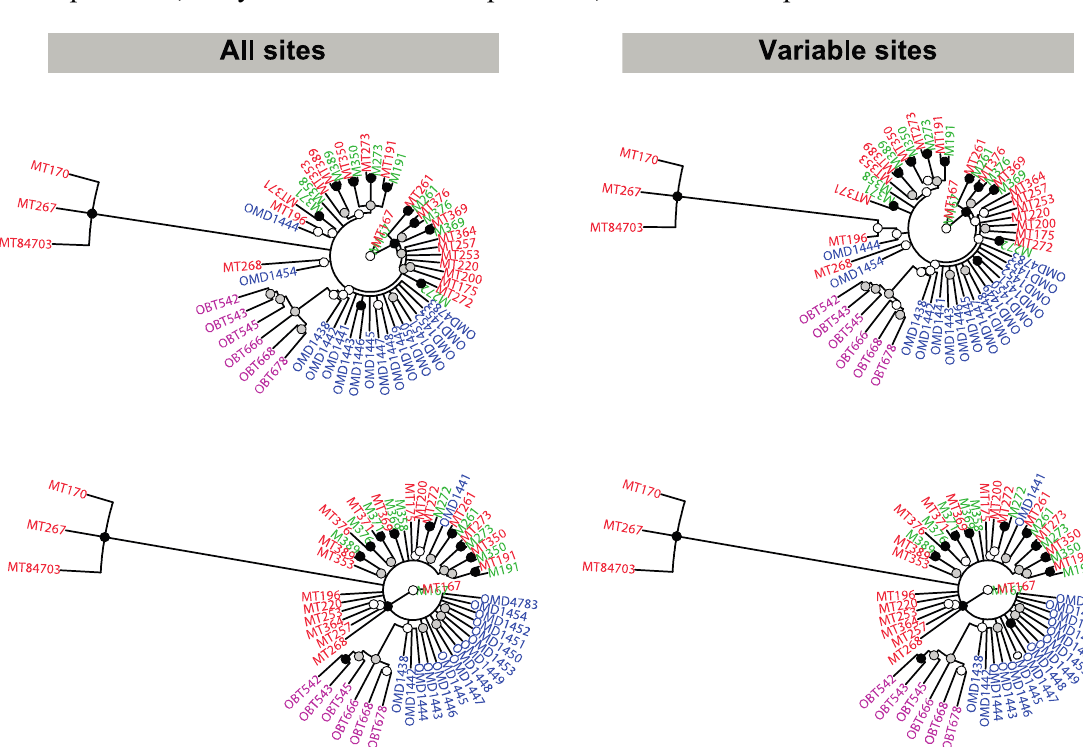
Figure 10. Unrooted consensus population trees obtained from MrBayes using different probability cutoffs. The top and bottom rows represent a probability cutoff for the presence of a CrERV of 0.01 and 0.99, respectively. The left and right columns represent the full dataset and a reduced dataset of only loci polymorphic for a CrERV, respectively. The analysis is based on the complete data set of 55 animals, which includes the 10 replicates. Oregon mule deer are shown in blue, Montana mule deer in red, replicate Montana mule deer in green, and Oregon black tail deer in magenta. Nodes have the following colors: Black: ≥ 0.95 posterior; Gray: ≥ 0.75 and < 0.95 posterior; White: < 0.75